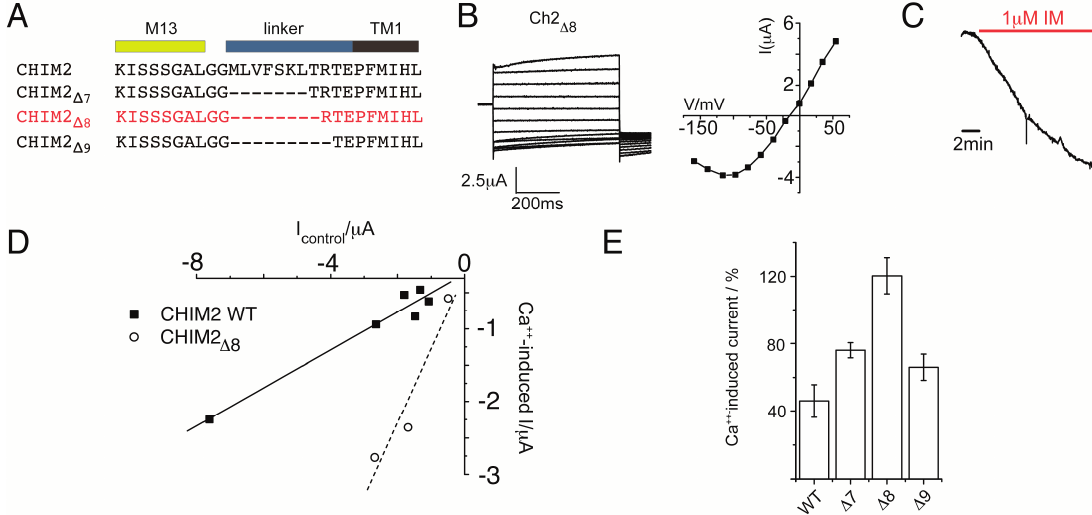
Figure 5. Molecular improvement of Chimera 2- ( A ) sequence alignment of the linker region in Chimera 2 (Chim2) and in the deletion mutants (Chim2 Δ 7 Chim2 Δ 8 Chim2 Δ 9 , lacking 7, 8 and 9 residues in the linker region (also known as Slide helix) connecting M13 sequence at the first transmembrane domain of Kcv (TM1); ( B ) left, exemplary current traces recorded from Chim2 Δ 8 by two-electrode voltage clamp applying the same voltage protocol of Figure 3. The corresponding I/V relationship is shown in the same panel (right); ( C ) IM-induced current increase recorded in Chim2 Δ 8 measured under constant voltage clamp at − 80 mV; ( D ) Ca ++ -induced current increase measured in Chim2 (black square) and Chim2 Δ 8 (open circle) plotted as a function of the initial current value (recordings obtained in all cases at − 80 mV); ( E ) comparison of Ca ++ -induced current increase (%) in the three deletion chimera ( Δ 7, Δ 8 and Δ 9) and Chim2